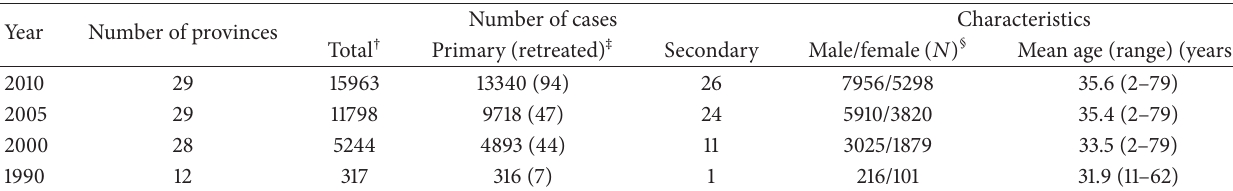
Table 3: Total number of BCS cases reported by the end of 4 setting